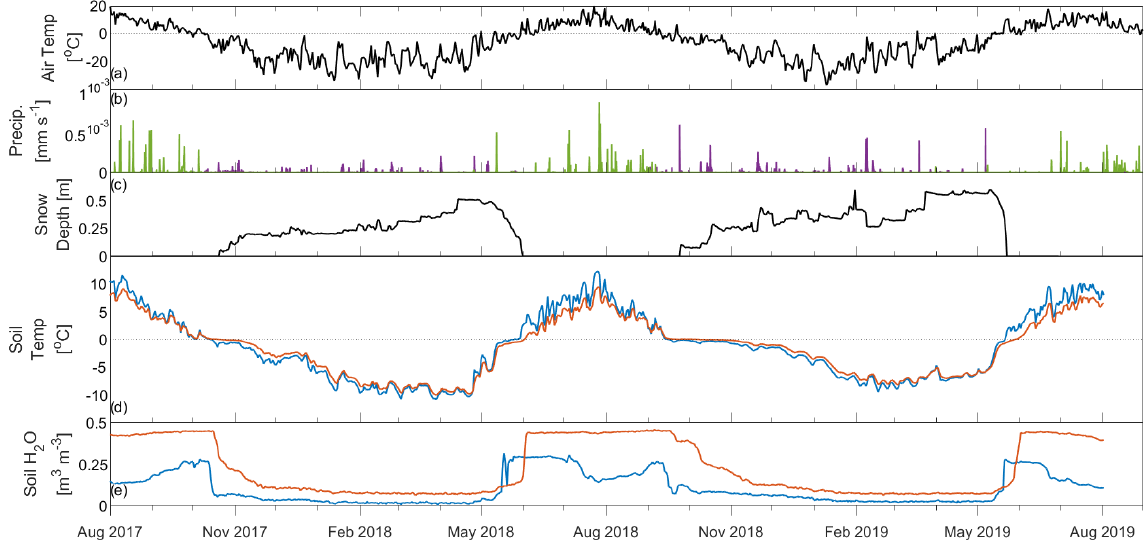
Figure 1. Daily averaged meteorological and soil conditions at Trail Valley Creek from 1 August 2017 to 31 August 2019: (a) 2m air temperature, (b) precipitation as snow (purple) and rain (green), (c) snow depth, (d) soil temperatures at depths of 5cm (blue) and 20cm (orange), and (e) volumetric soil water content at 5cm (blue) and 20cm (orange) depths.